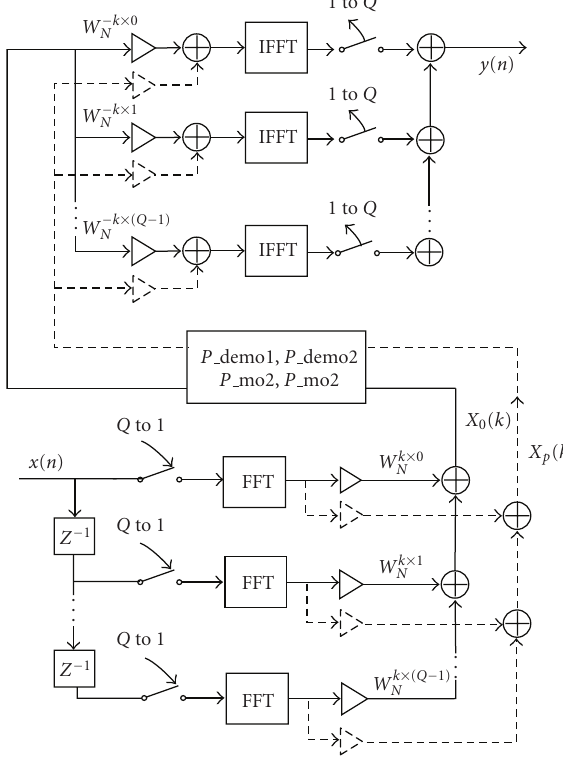
Figure 8: Structure of decimation and